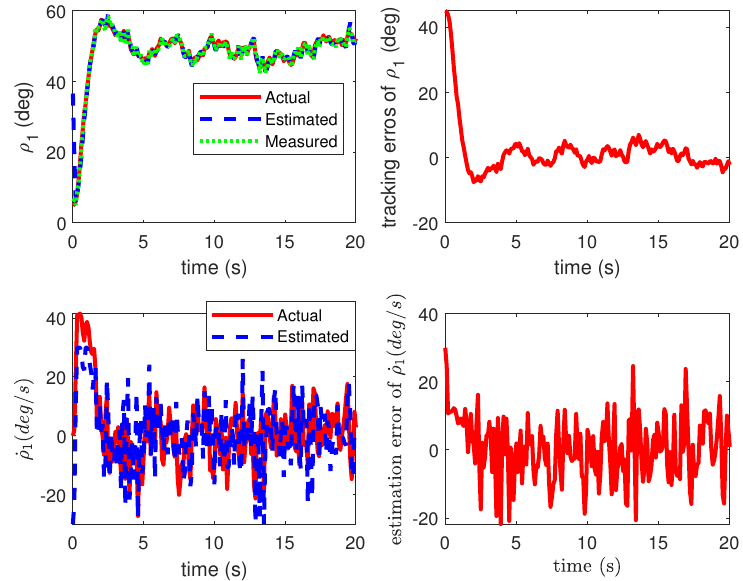
Figure 12. Case 3: state variables ρ 1 , ˙ ρ 1 and their tracking/estimation